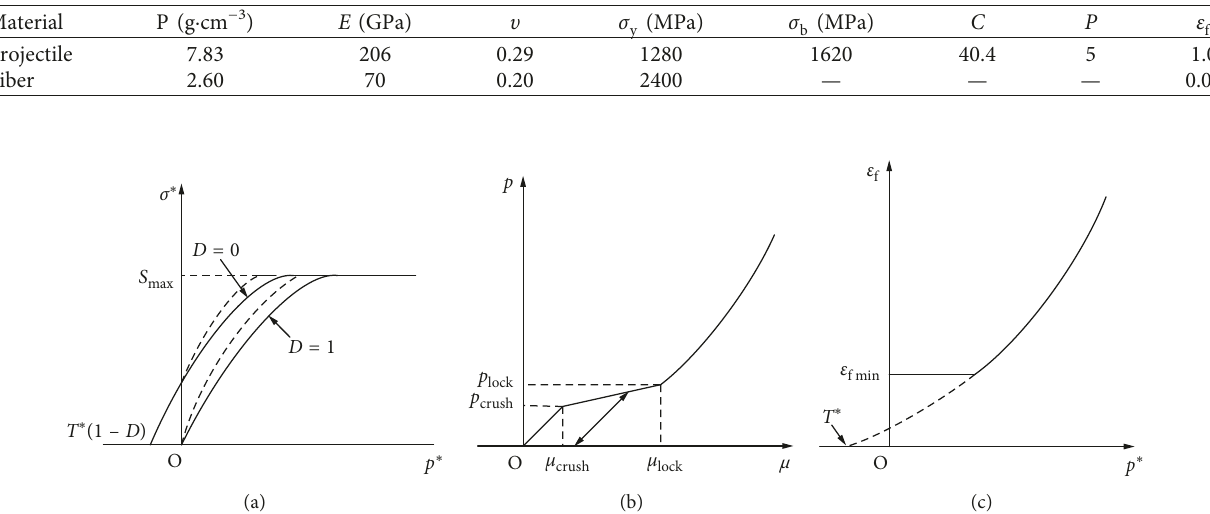
Table 5: Material parameters for the projectile and fiber.